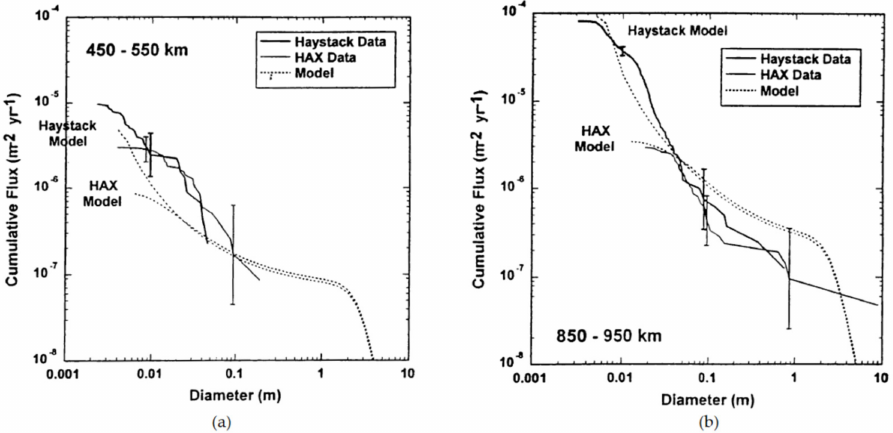
Figure 6. Comparison of Haystack and HAX measured debris size distributions for the altitude intervals 450–550 km ( a ) and 850–950 km ( b ) [18]. Reprinted from Proceedings of the Second European Conference on Space Debris, Copyright 1997, with permission from